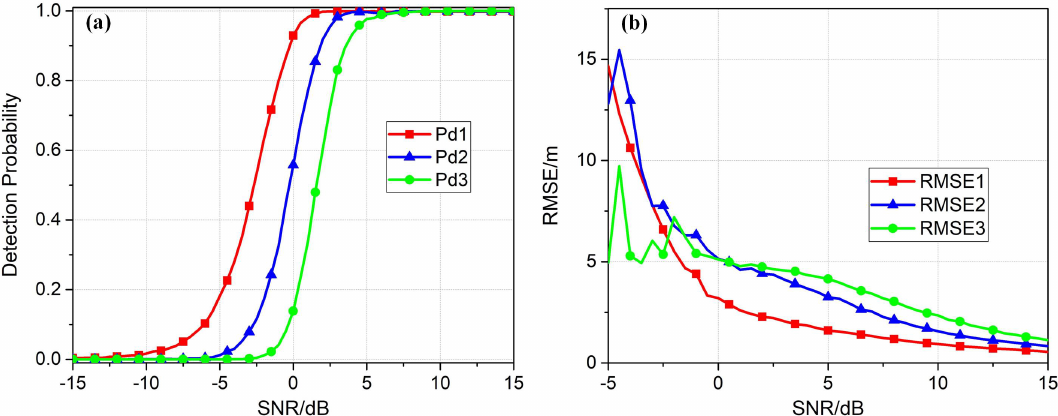
Figure 7. Performance of the proposed CS-GLRT for single (red, square), double (blue triangle) and triple (green, circle) scatterers, respectively: ( a ) detection probability; and ( b ) RMSE of the